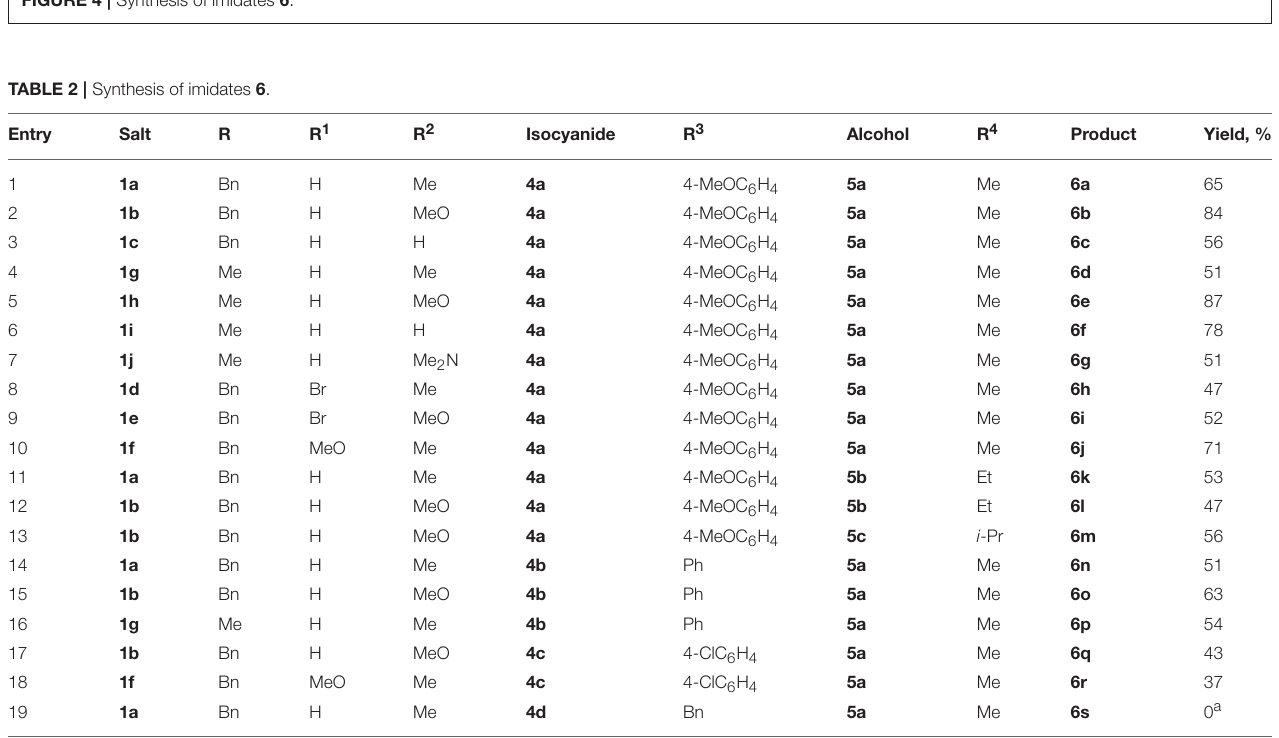
FIGURE 4 | Synthesis of imidates 6 .